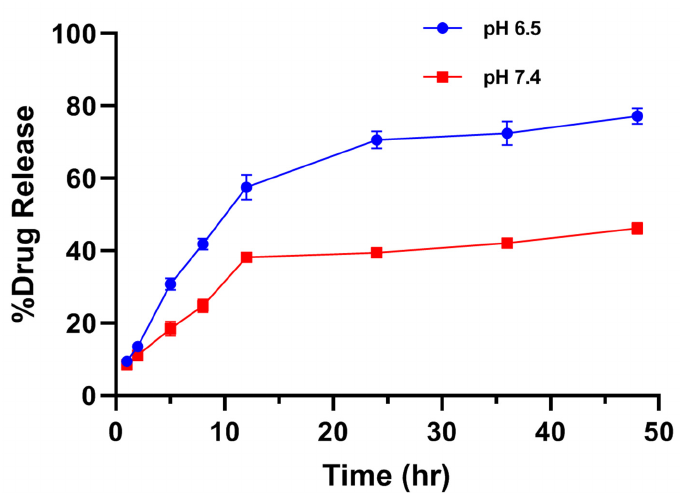
Figure 5. In vitro release profile of Diosgenin-loaded nanoparticles (PCL-F68-D-NPs) in phosphate-buffered saline (PBS) (pH 6.5 and pH 7.4) for 48 h. The data represent ± SEM of n = 3.